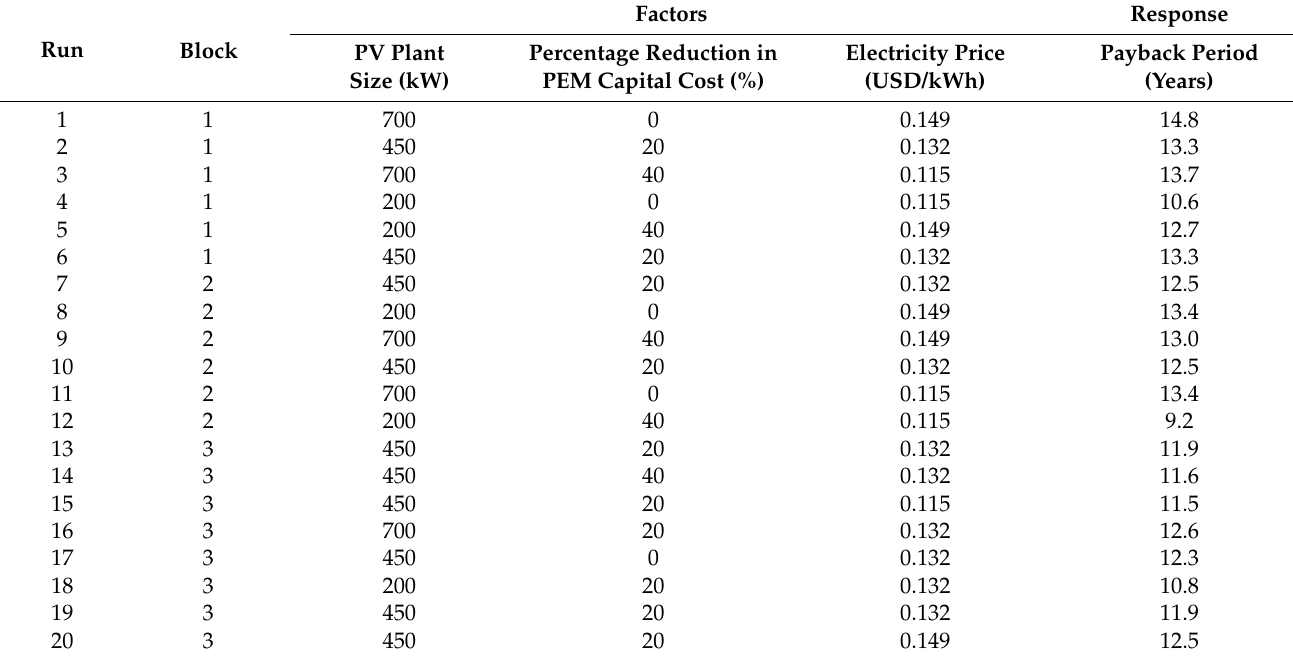
Table 7. Design matrix and results of the Face-Centered Central Composite design.